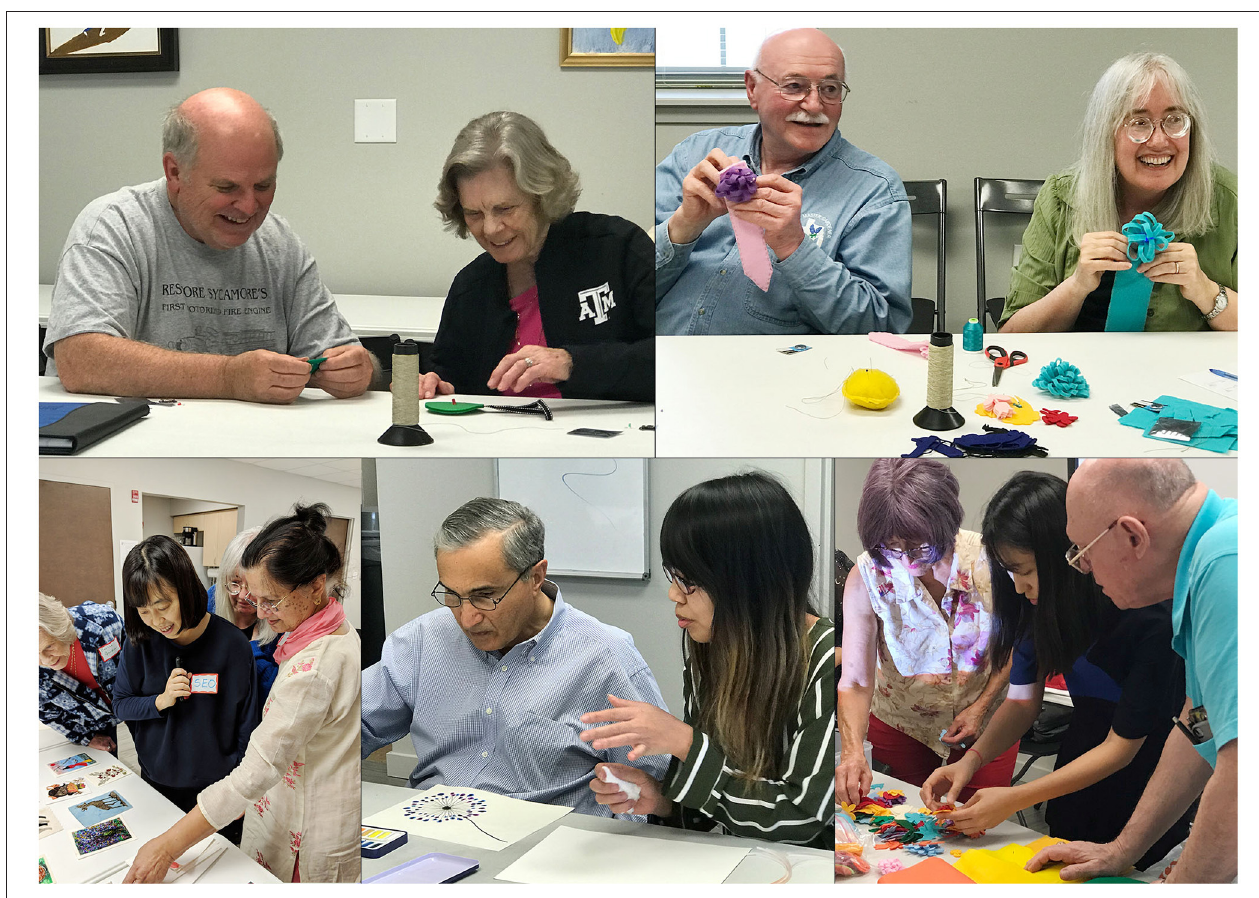
FIGURE 4 | Participants working collaboratively in the ATIC